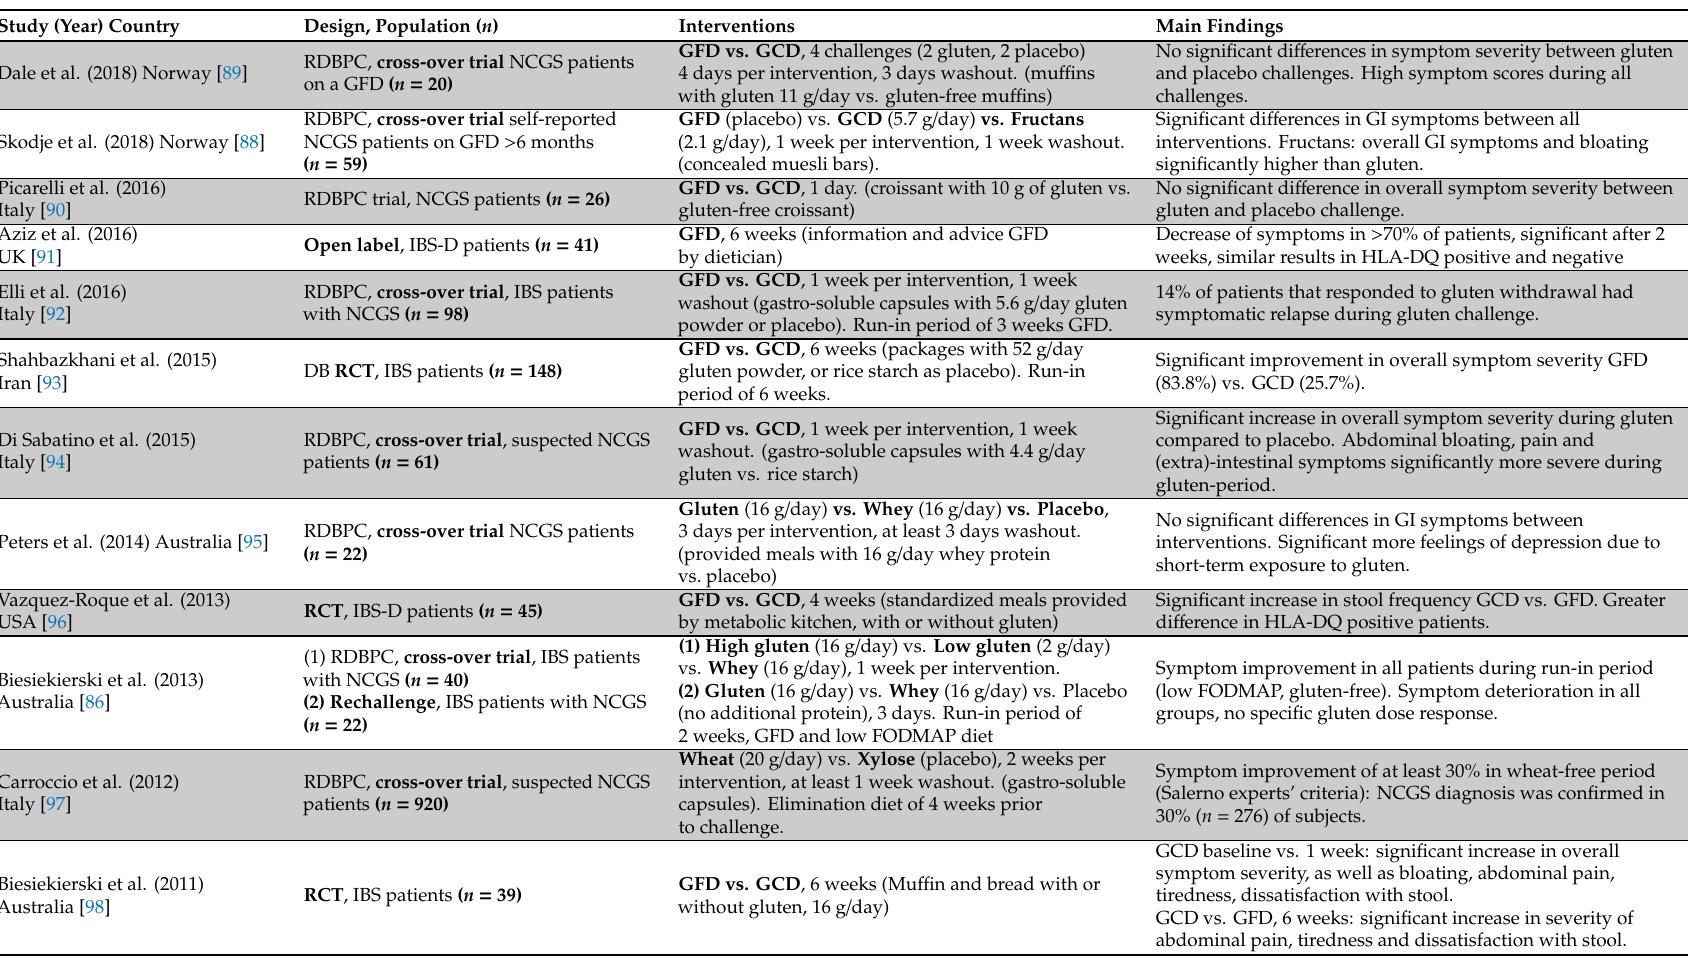
Table 2. Studies assessing the role of gluten in patients with IBS and / or non-celiac gluten (or wheat)